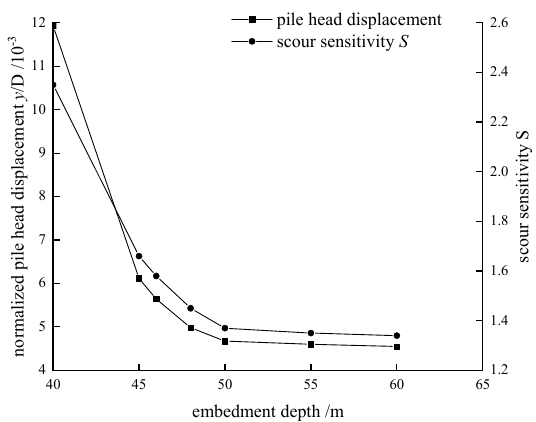
Figure 17. Pile displacement and scour sensitivity variation with embedment depth.